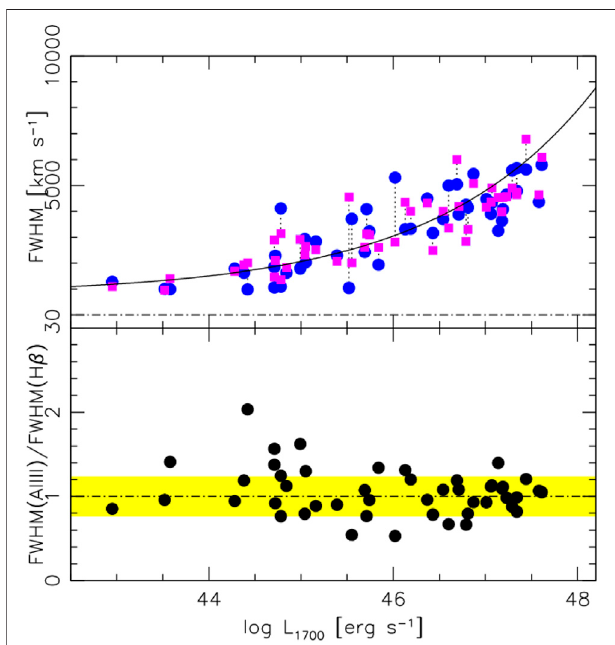
FIGURE 14 | The relation between FWHM of H β (blue) and Al III λ 1860 (magenta) and their FWHM ratio (bottom panel) , and bolometric luminosity. The fi lled line represents the trend FWHM ∝ L 1/4 , with arbitrary normalization. The yellow band de fi nes the uncertainty range in the ratio FWHM Al III λ 1860/FWHM H β .